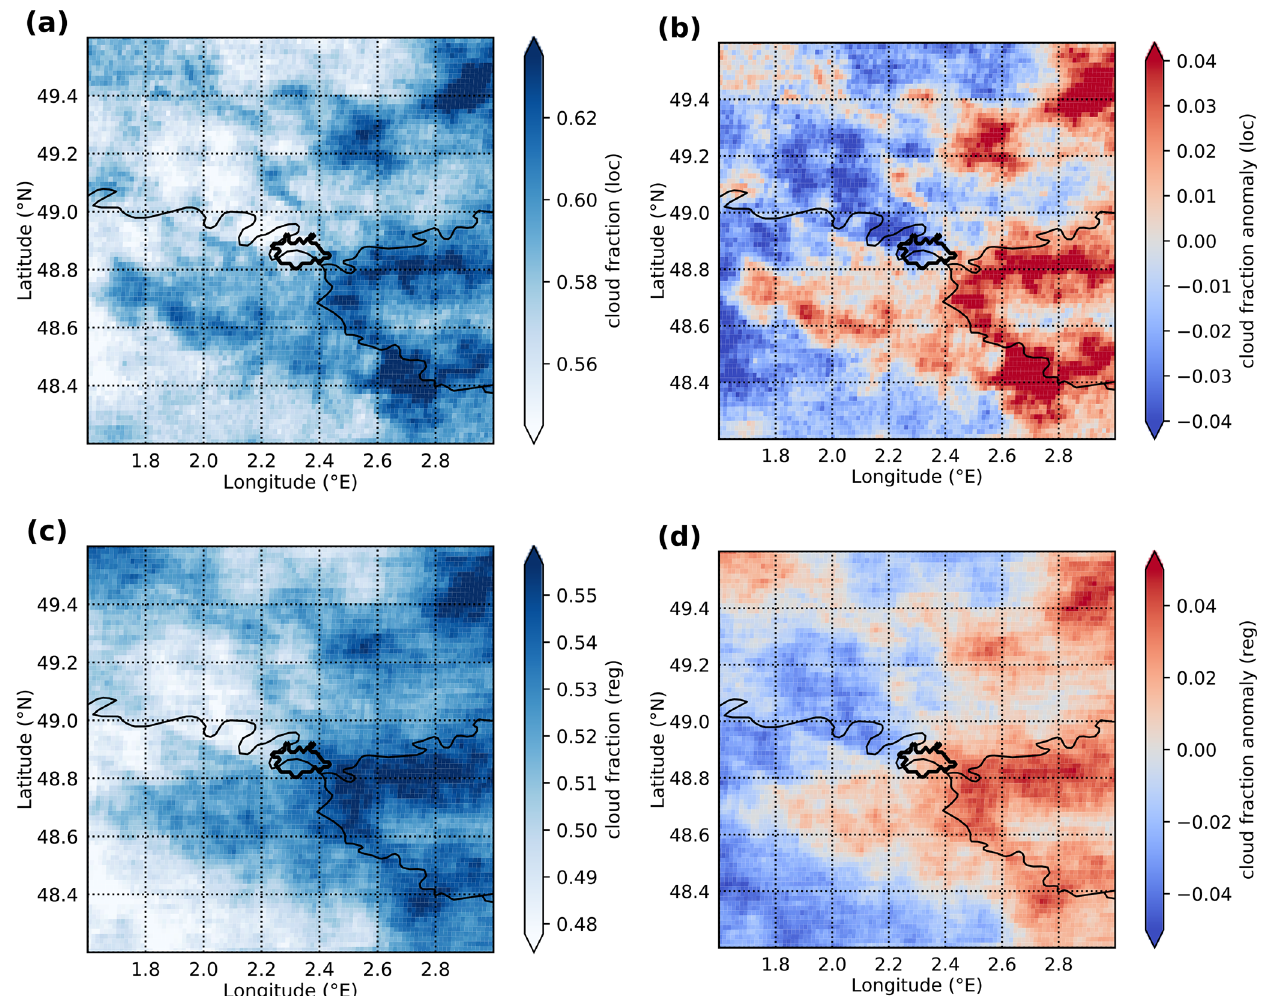
Figure 3. Cloud fraction CF loc and CF reg (a,c) and their spatial anomalies CF loc anomaly and CF reg anomaly (b,d) over the region of interest for the month of November during the years 2004–2019. Larger rivers are visualised as black lines, and the continuous urban area of Paris is shown as a black